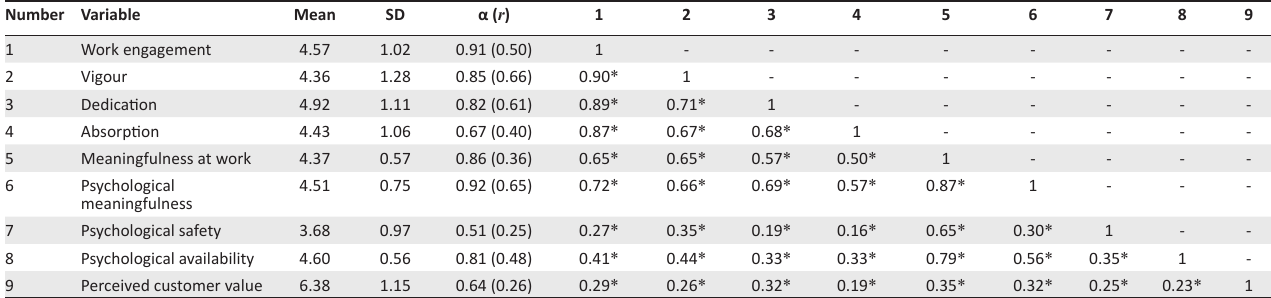
TABLE 1: Descriptive, reliability and correlation results. Number